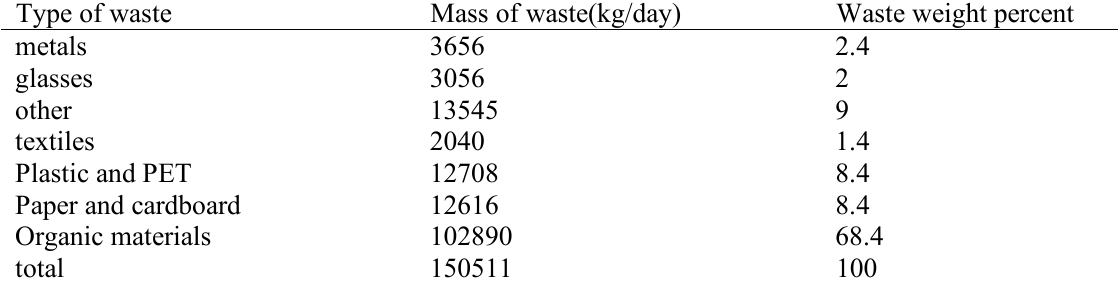
Table 1 . MSW components and characteristics in Sirjan city